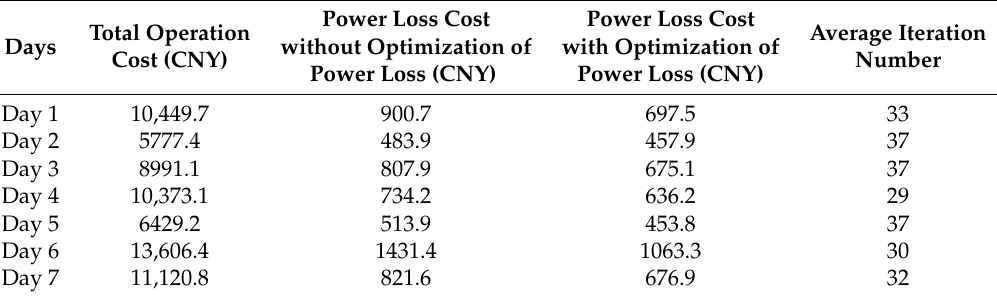
Table 3. Optimal results on different days for one week.